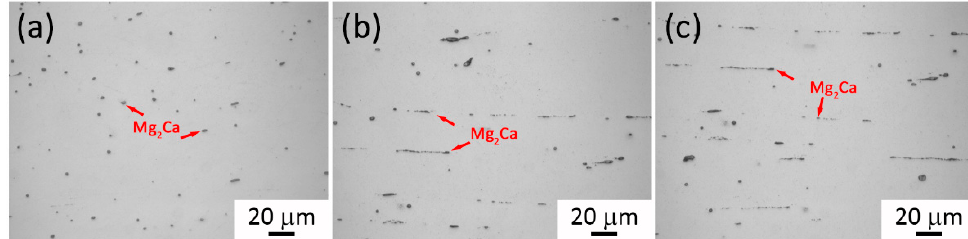
Figure 3. Optical micrographs without etching of the as-extruded ZX10 alloy showing the distribution of second phase precipitates: ( a ) 300 ◦ C, ( b ) 350 ◦ C, and ( c ) 400 ◦ C. The precipitates were marked by red arrows.